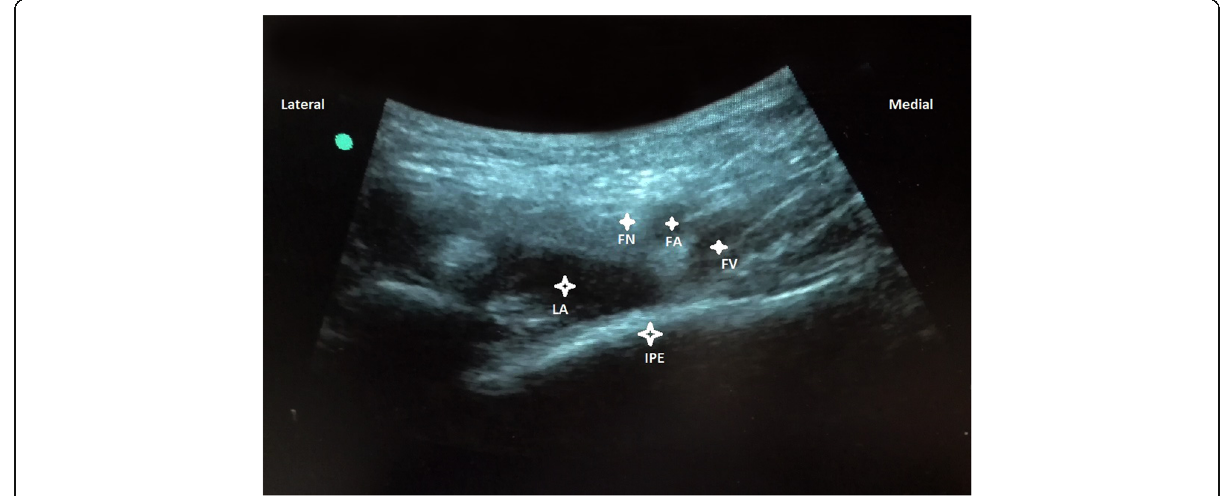
Fig. 4 Femoral nerve (FN), artery (FA), vein (FV), Iliopubic eminence (IPE), Local anesthetic mixture